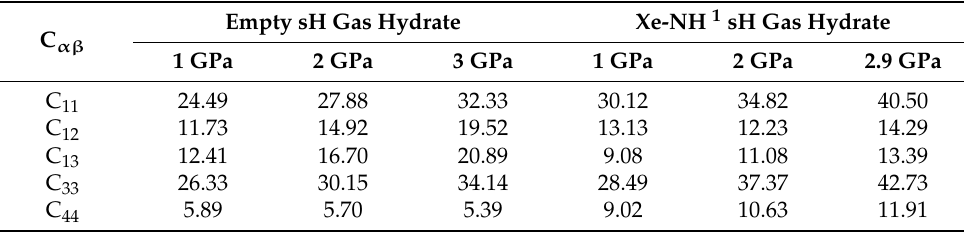
Table 2. Elastic constants (C αβ ) of empty and Xe-NH sH gas hydrates under pressure and at 0 K. Empty sH Gas C αβ